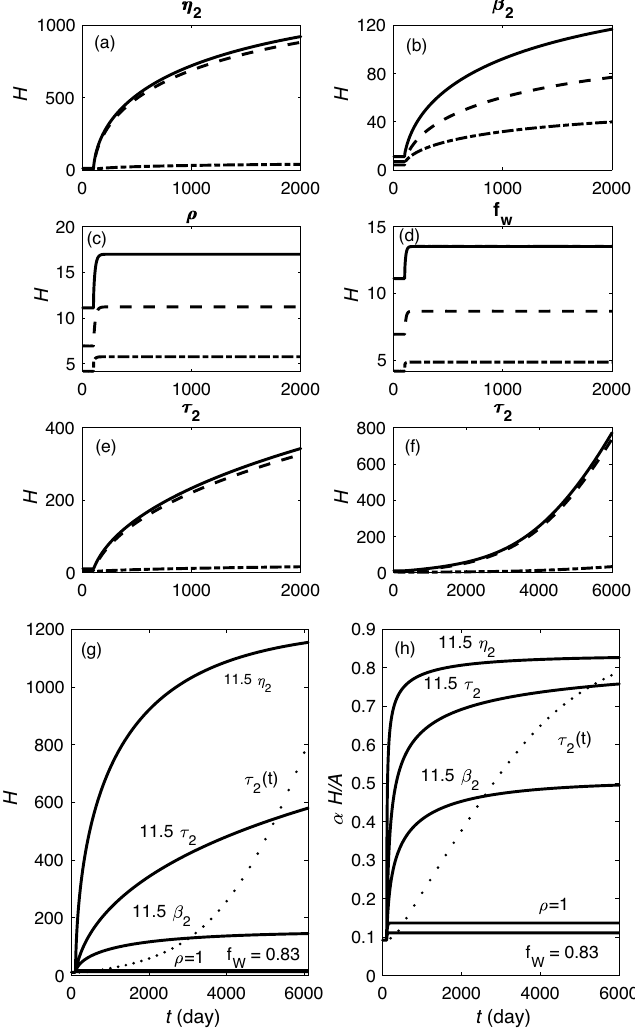
Figure 5. Runaway predictions for the two species. ( a )–( e ) Demonstrate the case of a sudden change of one parameter at t = 100 days, as labeled: ( a ) η 2 is 11.5 times higher than the best-fit value from Table 1, ( b ) β 2 is 11.5 times the best-fit value, ( c ) ρ = 1 , ( d ) f W is increased to 0.83 which indicates 20 h of wakefulness, and ( e ) τ 2 is 11.5 times larger. In each case the dot-dashed line indicates H 1 , the dashed line H 2 , and the solid line, the total H . ( f ) Shows results for a gradual increase of τ 2 over time, with an increase by a factor of 11.5 being reached at t = 3500 days. ( g ) Comparison of total H for the conditions in ( a )–( e ), as labeled; dotted line shows case ( f ). ( h ) Corresponding void blockage fraction for the conditions in ( a )–( f ). All other parameters are set at their best-fit values from